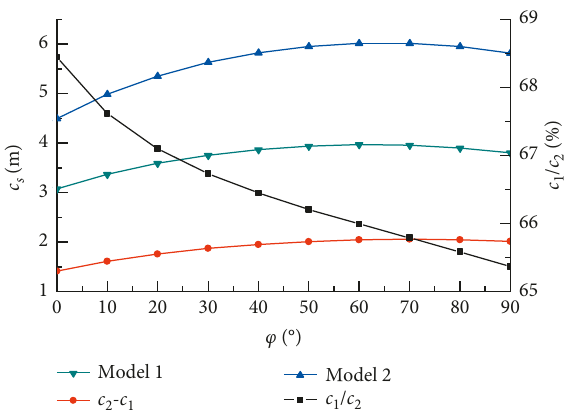
Figure 6: Diagram of the minimum thickness with the inclination angle of the orebody.